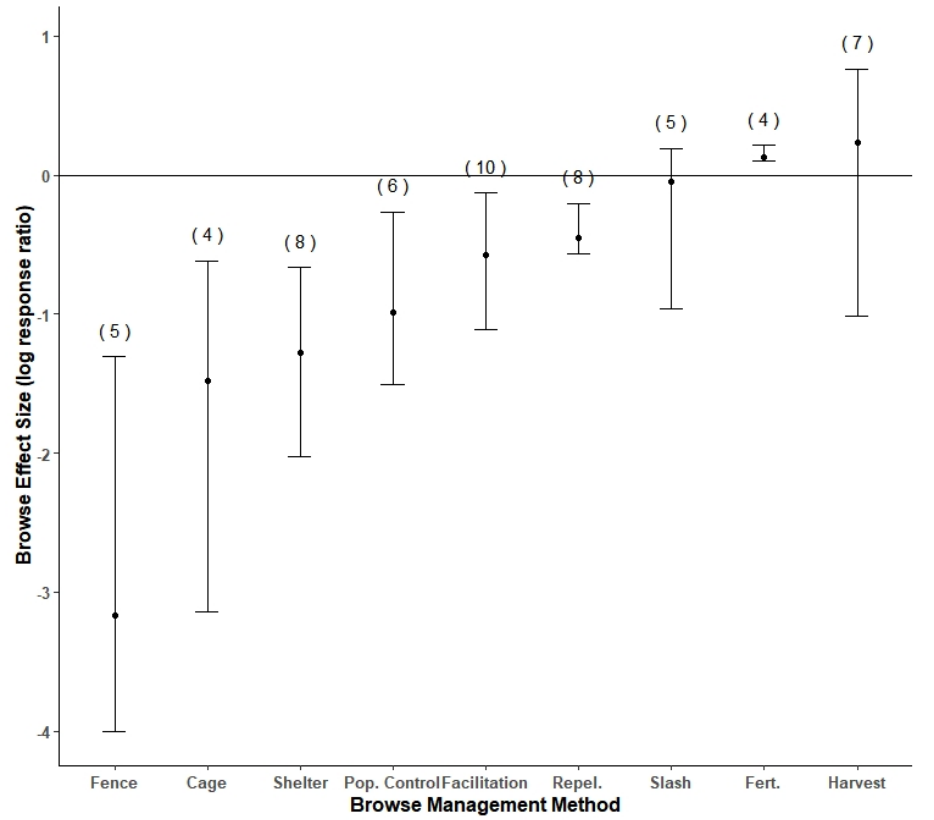
Figure 2. Mean and 95% confidence limits of browsing effect size (log response ratio) among nine categories of browse management. Numbers in parentheses represent the number of individual studies used for each method.